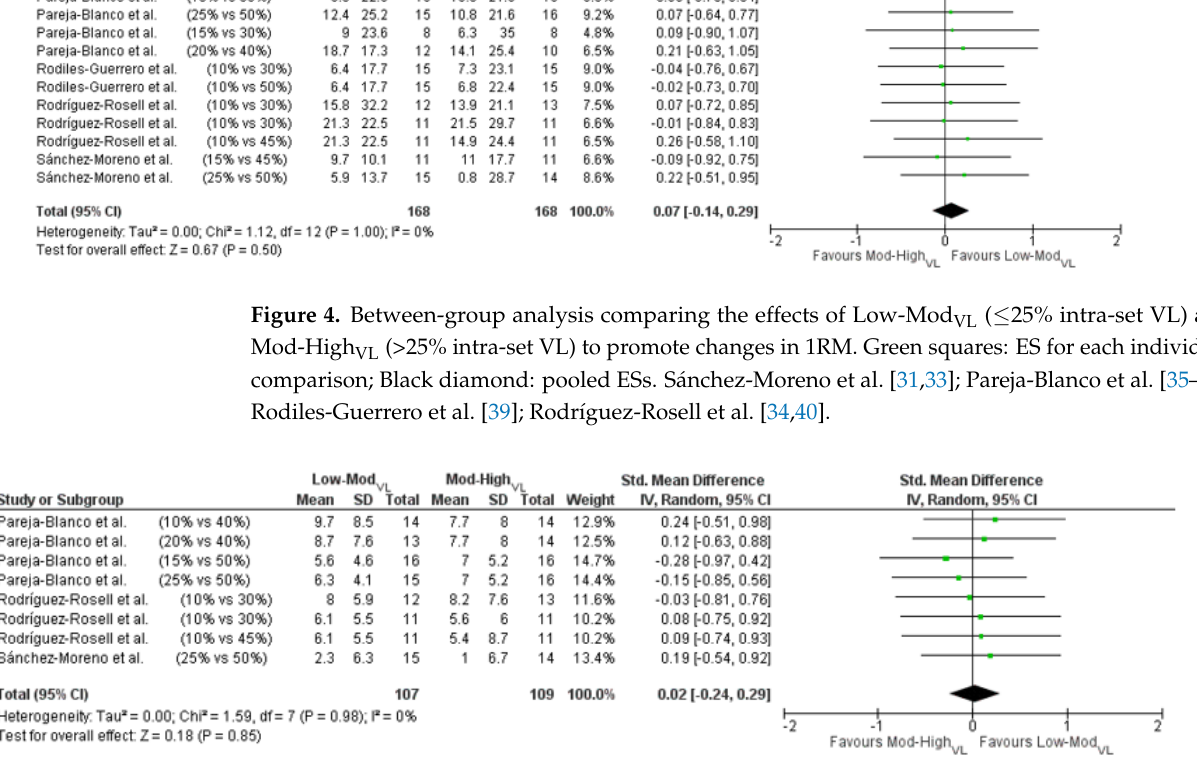
Figure 5. Between-group analysis comparing the effects of Low-Mod VL ( ≤ 25% intra-set VL) and Mod-High VL (>25% intra- set VL) to promote changes in local muscle endurance. Green squares: ES for each individual comparison; Black diamond: pooled ESs. Sánchez-Moreno et al. [31]; Pareja- Blanco et al. [35,36]; Rodríguez -Rosell et al. [34,40].